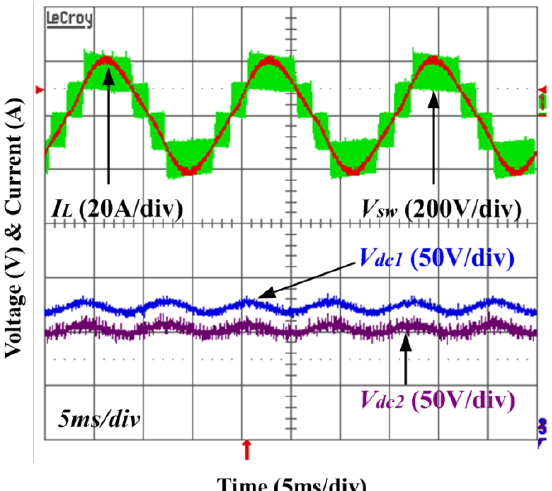
Figure 14. Experimental results of DC link voltage and grid current control when the MPP voltage of upper H-bridge module and lower H-bridge module are 120 and 100 V respectively.